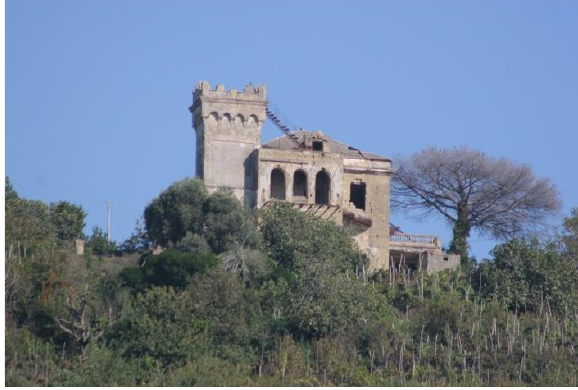
Figure 4. Masseria degli Spadari , fortified farmhouse in the neighbourhood of Pianura